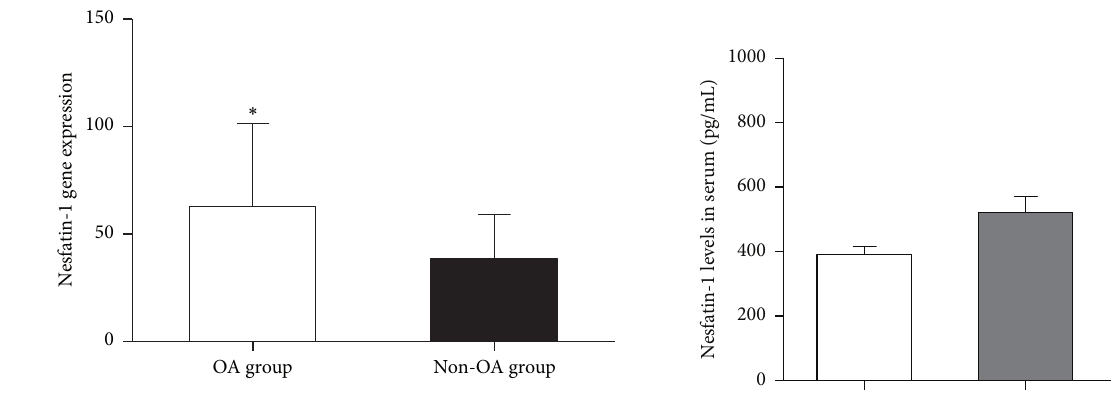
Figure 2: Nesfatin-1 gene expression in OA and non-OA cartilage. Nesfatin-1 mRNA levels were significantly higher in patients with OA than in femoral neck fracture controls ( ∗ 𝑃 < 0.05 ).